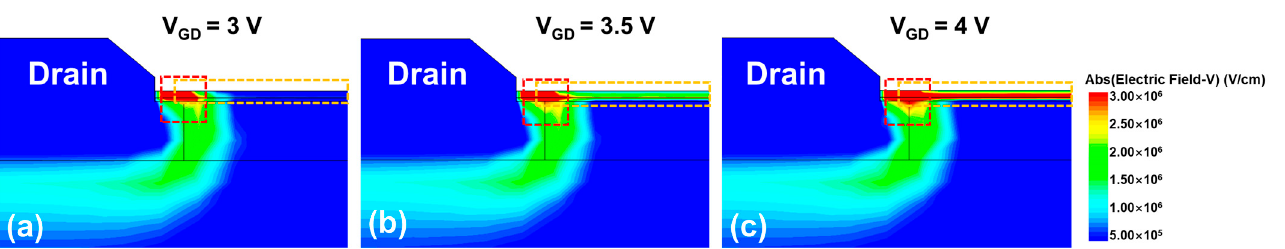
Figure 6. The 2-D view of electric field distributions under GIDL repairing process of ( a ) V GD = 3.0 V, ( b ) V GD = 3.5 V, and ( c ) V GD = 4.0 V.